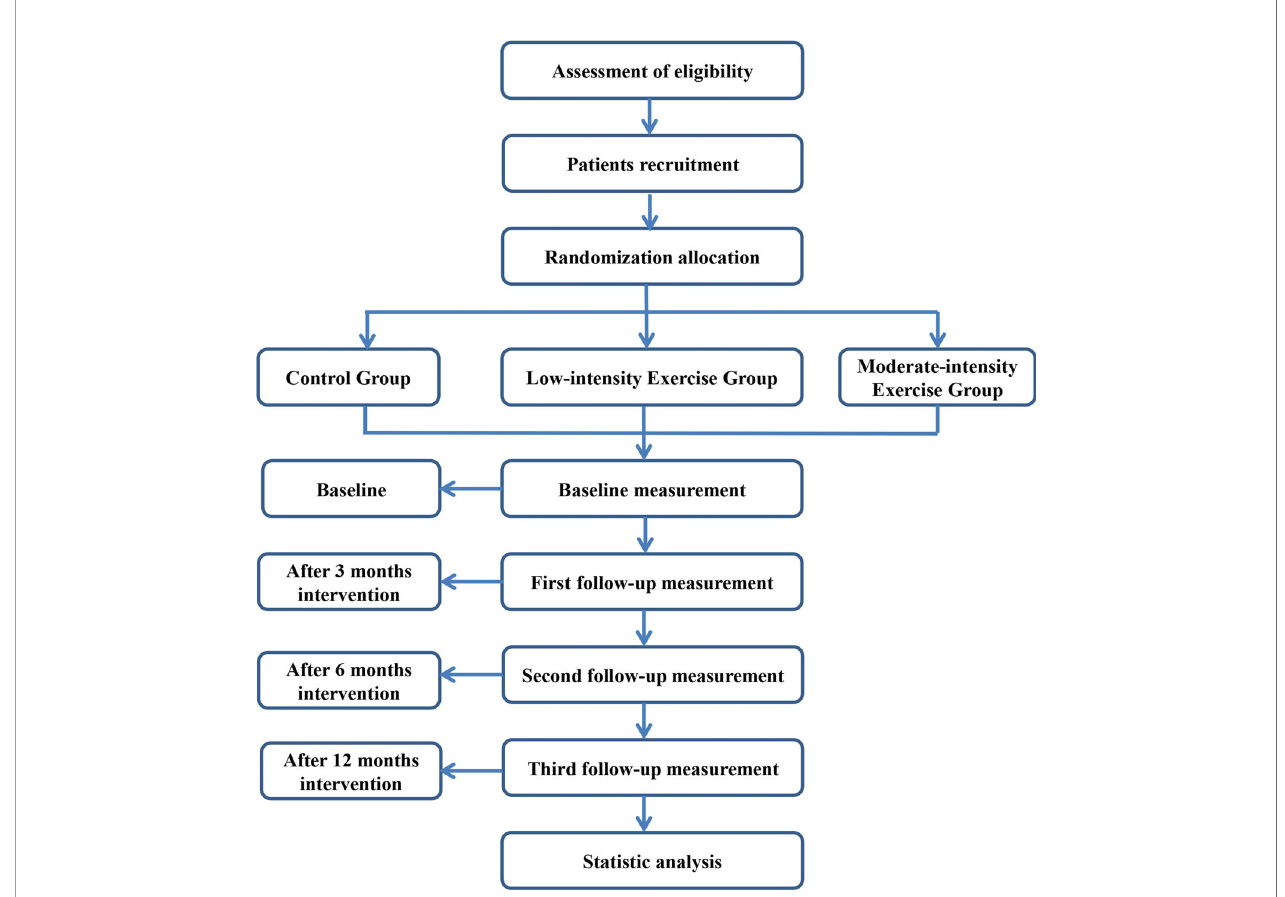
FIGURE 1 | Trail fl ow